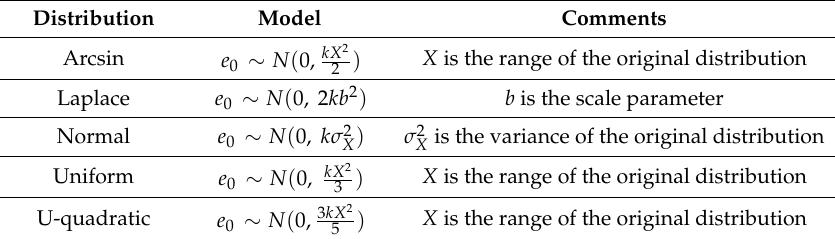
Table 2. Analytical models obtained for different probability distributions.